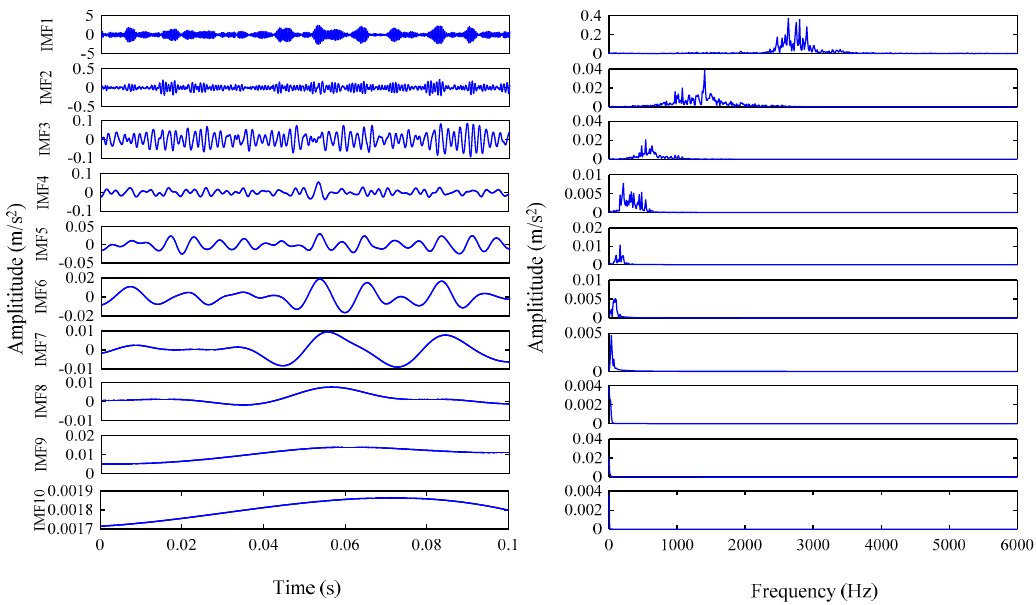
Figure 19. Decomposition results and corresponding frequency spectrum of IMFs for outer ring defect with EEMD.